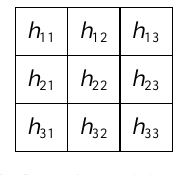
Fig 1. Slope calculating by grid data